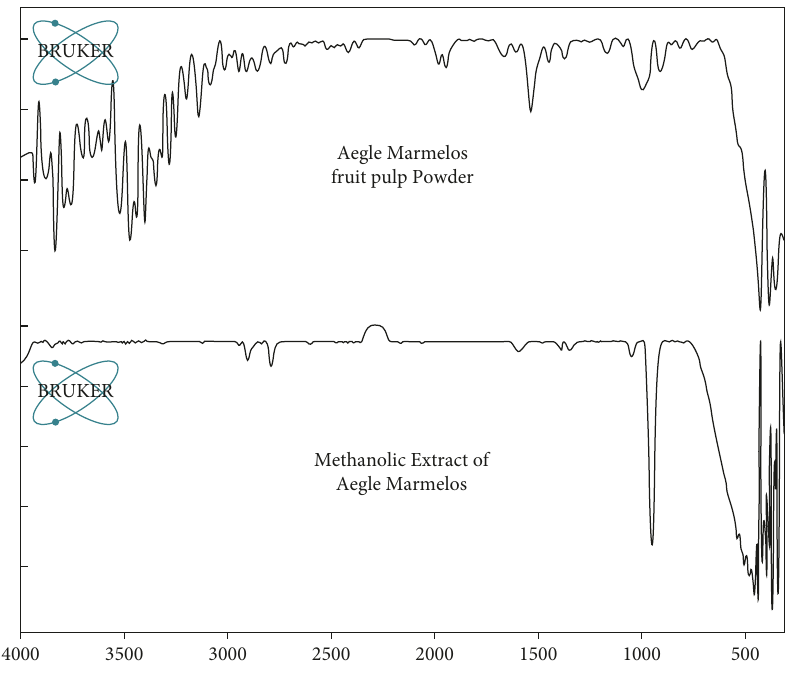
Figure 8: FTIR images of the Aegle marmelos fruit pulp powder and methanolic extract.